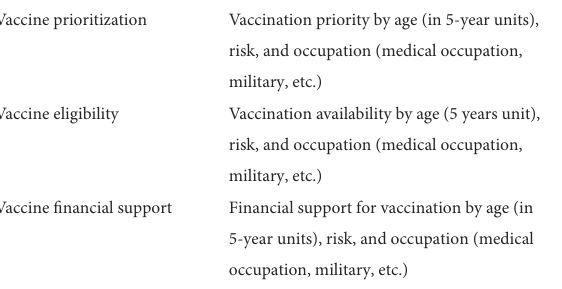
TABLE 3 COVID-19 vaccine policies from the OxCGRT